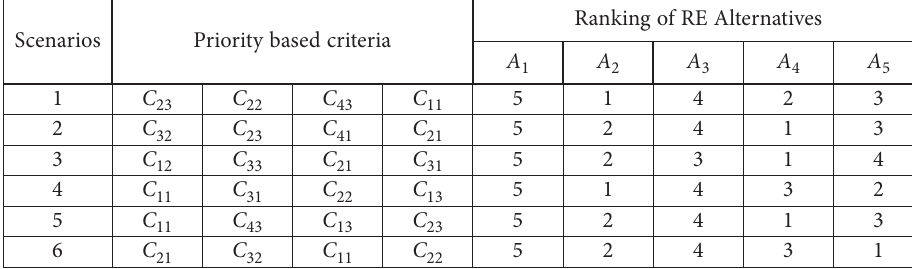
Table 12. Sensitivity of alternative ranking to changes in criterion weights taken on priority basis Scenarios